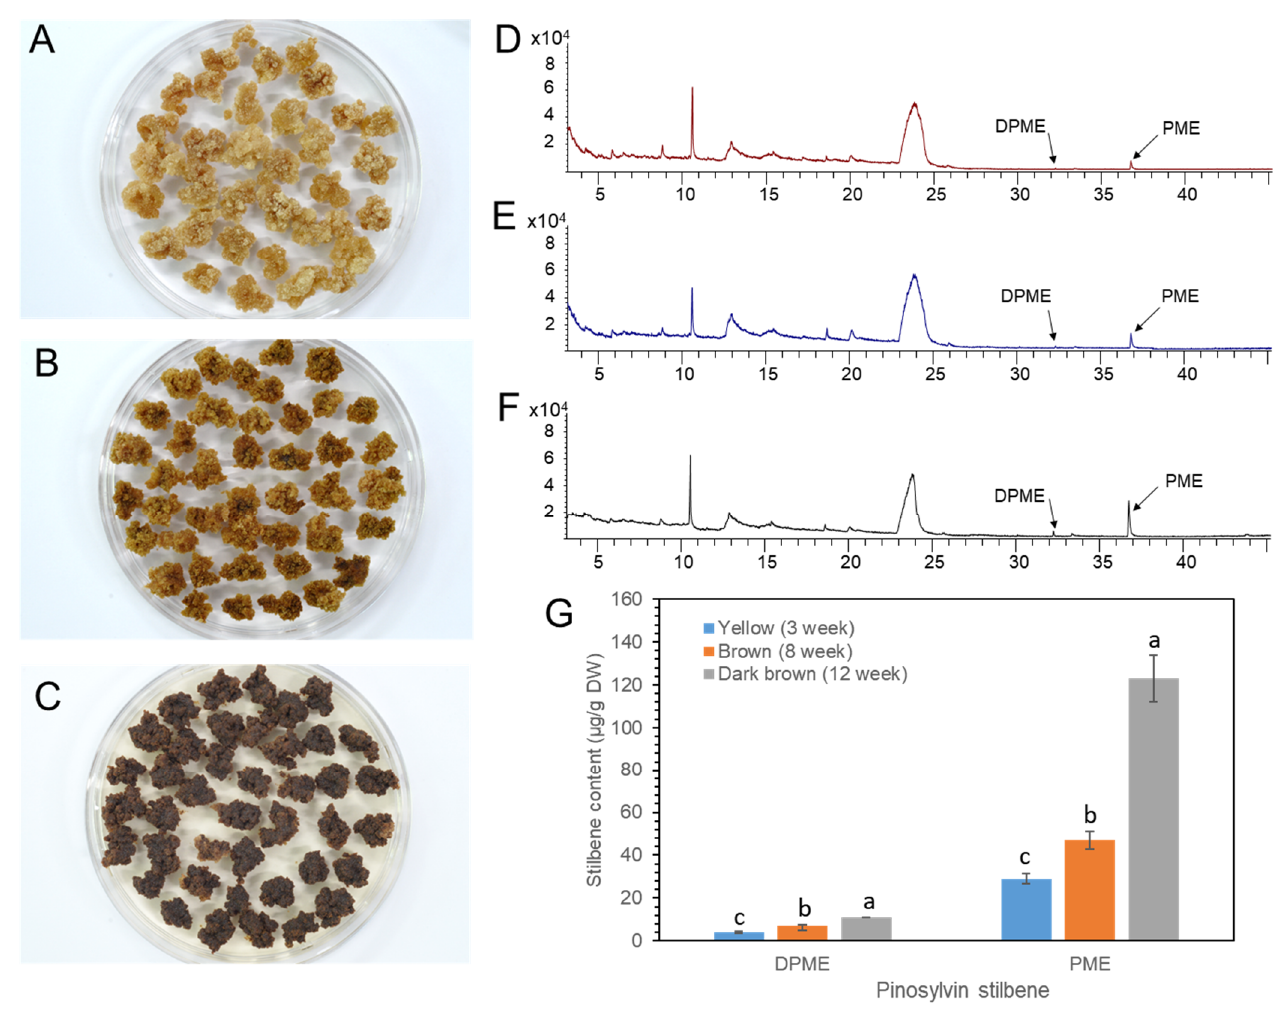
Figure 8. Ageing of P. koraiensis callus by prolonged culture and accumulation of DPME and PME in differently aged callus. ( A – C ) Photos of yellow ( A ), brown ( B ), and dark brown ( C ) calli after 3 weeks, 8 weeks, and 12 weeks of culture, respectively. ( D – F ) GC chromatogram of callus extracts from yellow ( D ), brown ( E ), and dark brown ( F ) calli. ( G ) Content of DPME and PME in calli with different ages. The analysis results are presented as the means ± SEs of three independent experiments, each performed in technical triplicates. Different letters above the bars indicate significantly different values ( p < 0.05), calculated using one-way ANOVA followed by Duncan’s post hoc analysis